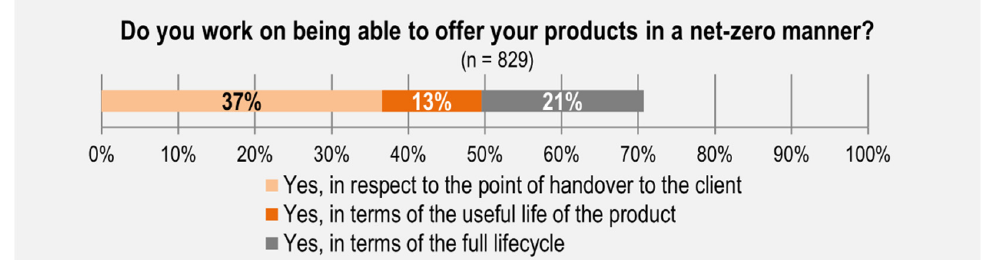
Figure 6. Companies’ goals in relation to their products’ carbon footprint [43].